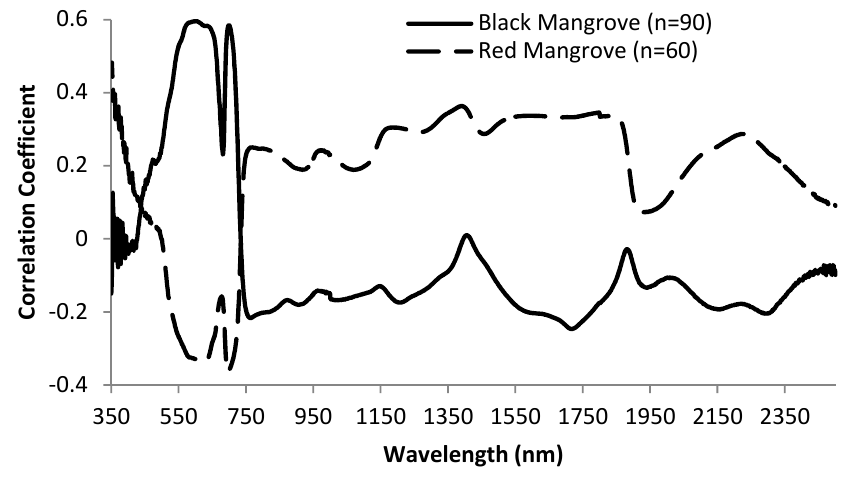
Figure 7. Correlations between mangrove leaf N concentration and leaf